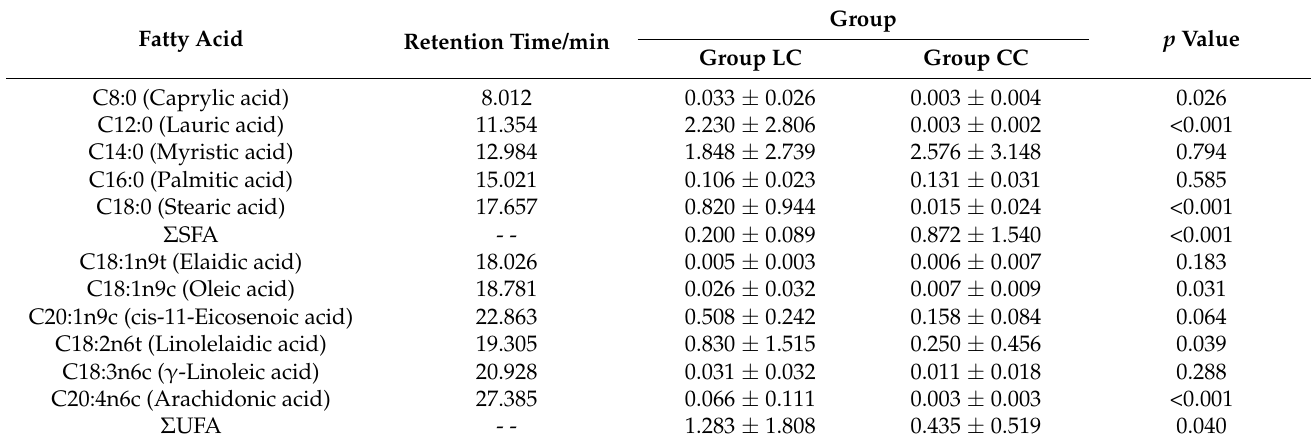
Table 2. The composition of yolk fatty acid in Huainan Partridge chicken and Nongda III.